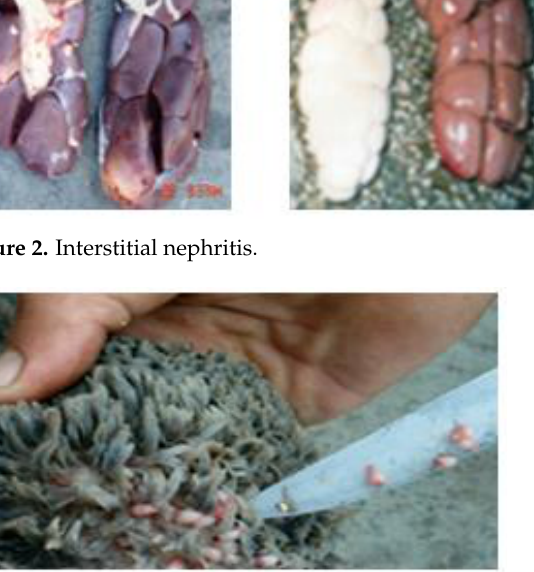
Figure 3. Paramphistomosis.